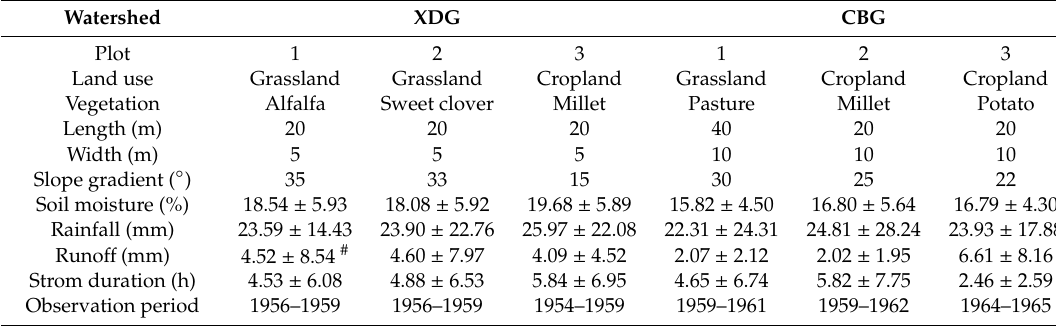
Table 1. Main characteristics of experimental plots in the XDG and CBG